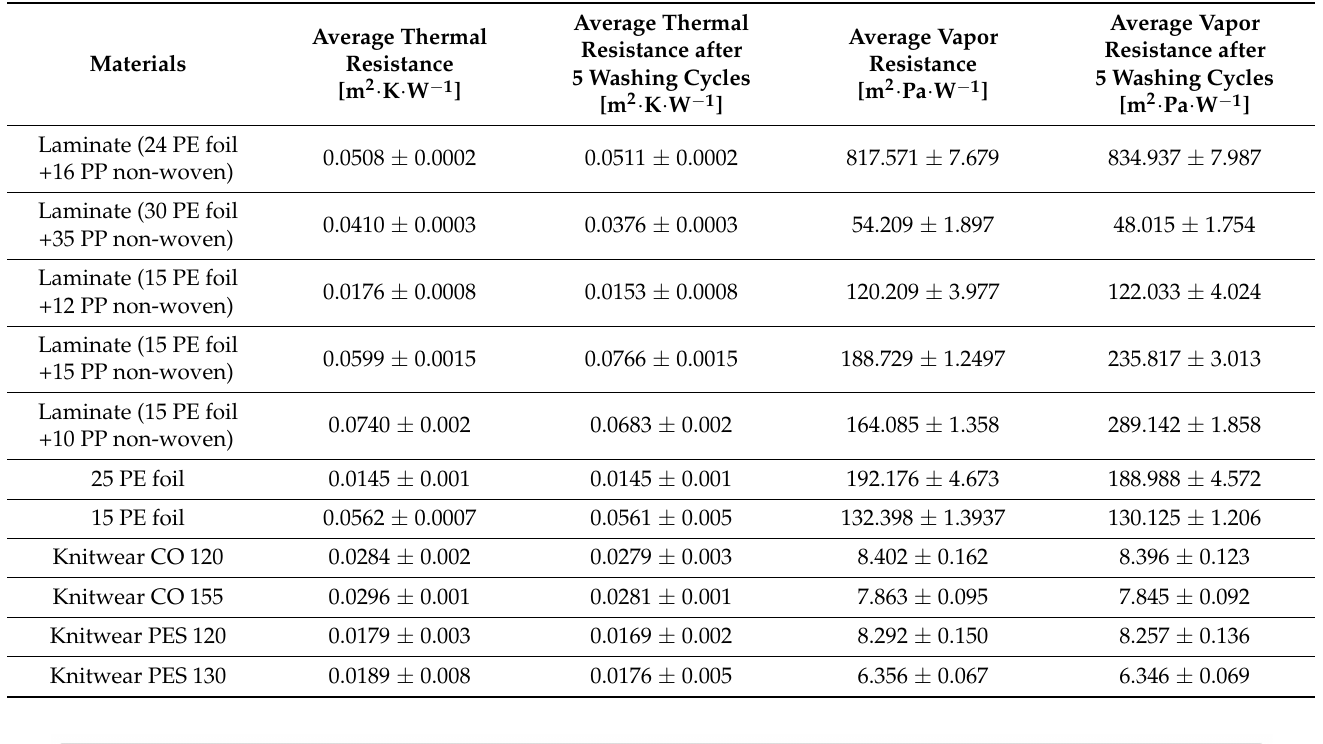
Table 4. The results of vapor resistance and heat resistance obtained for the tested materials.